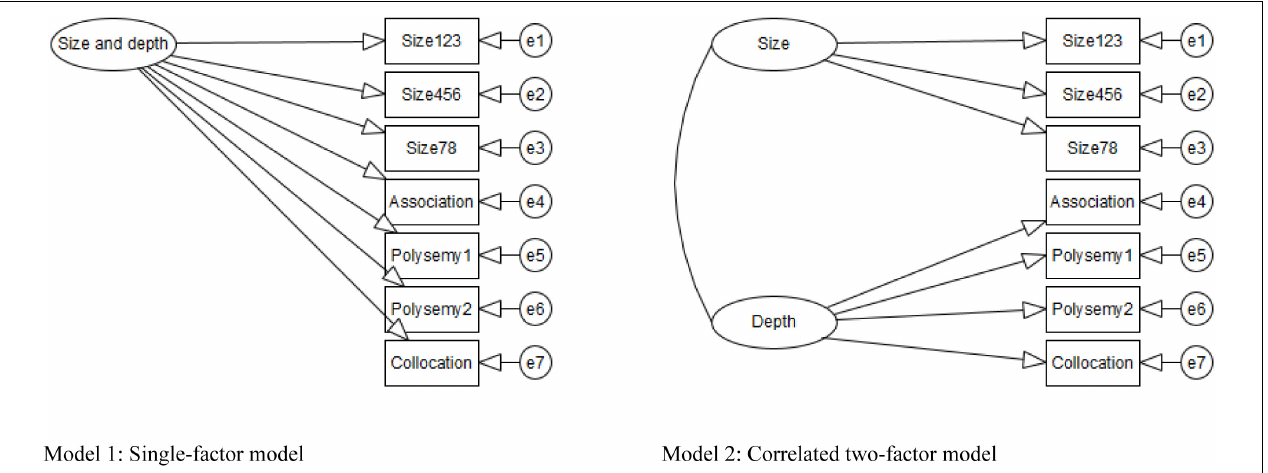
FIGURE 1 | Models of vocabulary size and depth using conventional structural equation modeling (SEM). Size123 = size with 1,000–3,000 levels; Size456 = size with 4,000–6,000 levels; Size78 = size with 7,000 and 8,000 levels. All figures in this article were created using yEd Graph Editor (Version 3.19.1.1; yWorks GmbH,